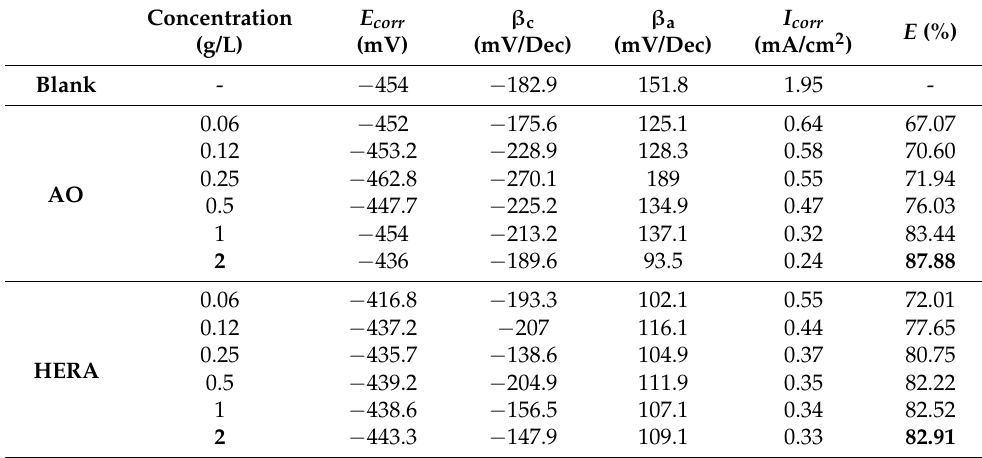
Figure 9. Polarization curves of mild steel in 1 M HCl in presence and absence of AO and HERA. Table 5. Potentiodynamic polarization descriptors of mild steel in 1 M HCl in presence and absence of AO and HERA.